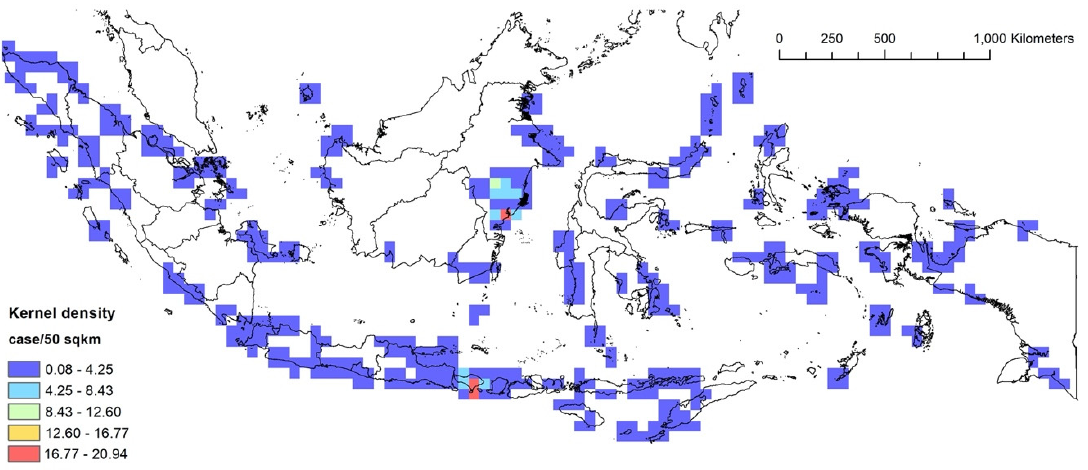
Figure 7. The kernel density analysis of the 2012–2021 stranding events based on the number of cases.